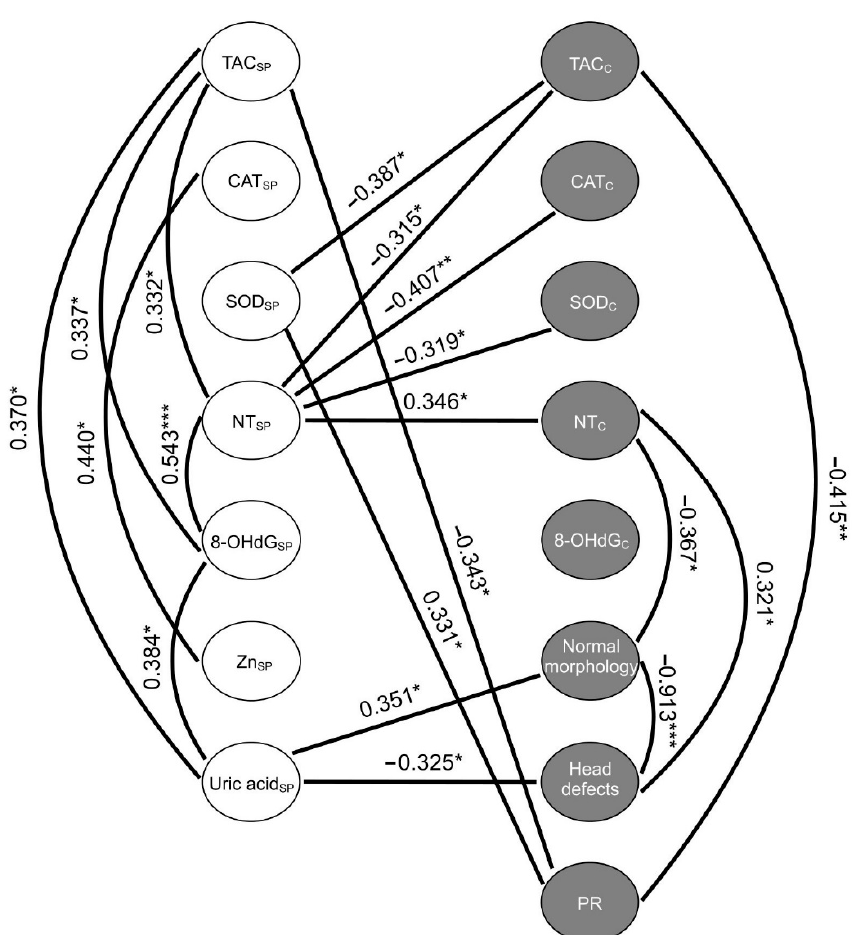
Figure 4. The correlation pleiades of the antioxidant components, markers of oxidative modification of proteins and DNA in seminal plasma and sperm, as well as some semen analysis characteristics in the general patient sample. PR—progressive motility; 8-OHdG—8-hydroxy-2 ′ -deoxyguanosine; CAT—catalase activity; NT—nitrotyrosine; SOD—superoxide dismutase activity; TAC—total antioxidant capacity; C (subscript)—cellular; SP (subscript)—in seminal plasma. The Spearman correlation coefficient was used to identify the strength and direction of relationship between studied